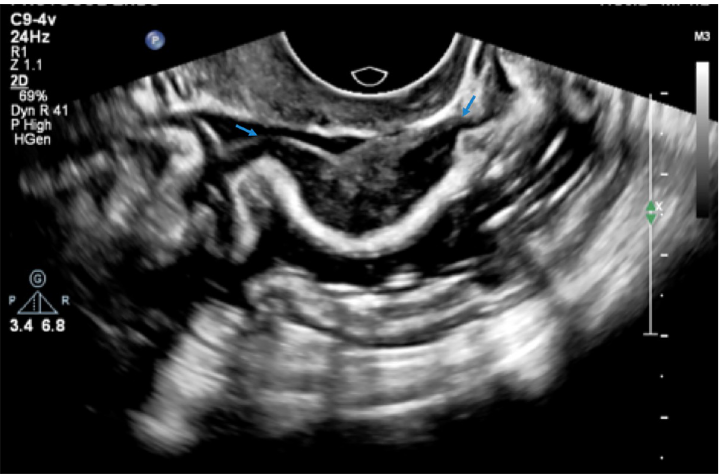
Fig 2. USTVBP image showing a longitudinal section of the sigmoid. Deep endometriosis nodule in the anterior wall with involvement up to the inner muscle layer (blue arrows).